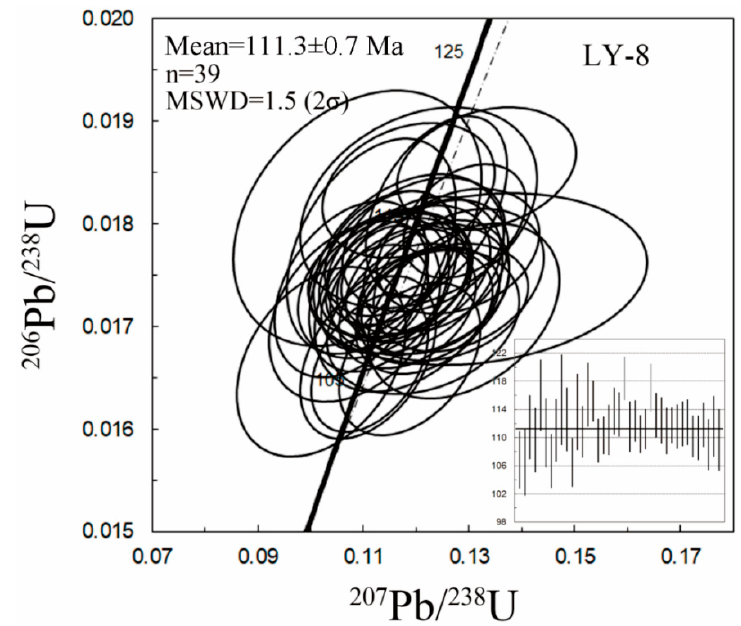
Figure 5. Zircon U-Pb Concordia diagrams for representative quartz monzonite and granite from the Muchen pluton.